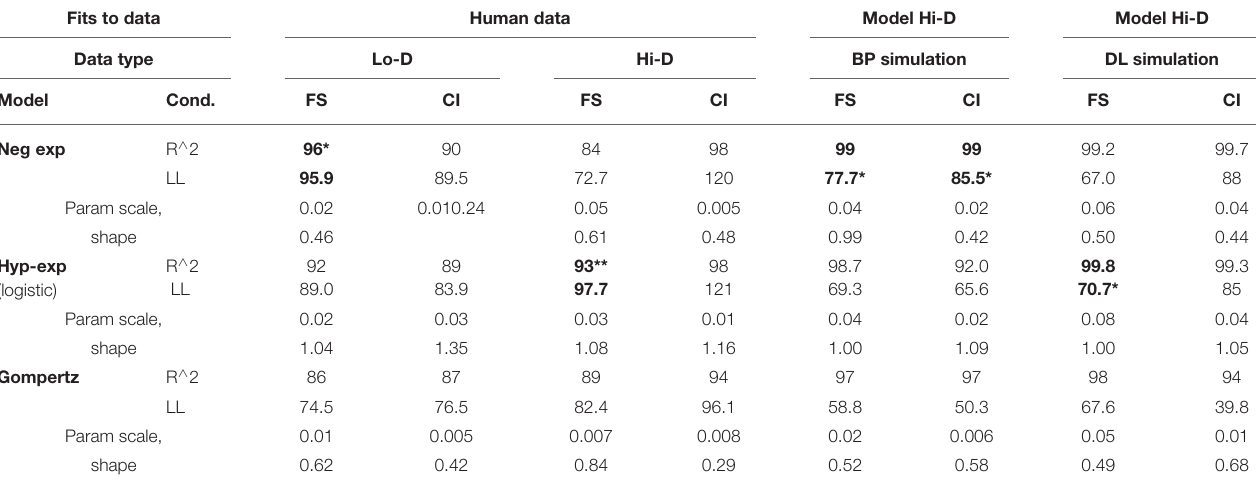
TABLE 1 | Model fits to subject and simulation learning. Fits to